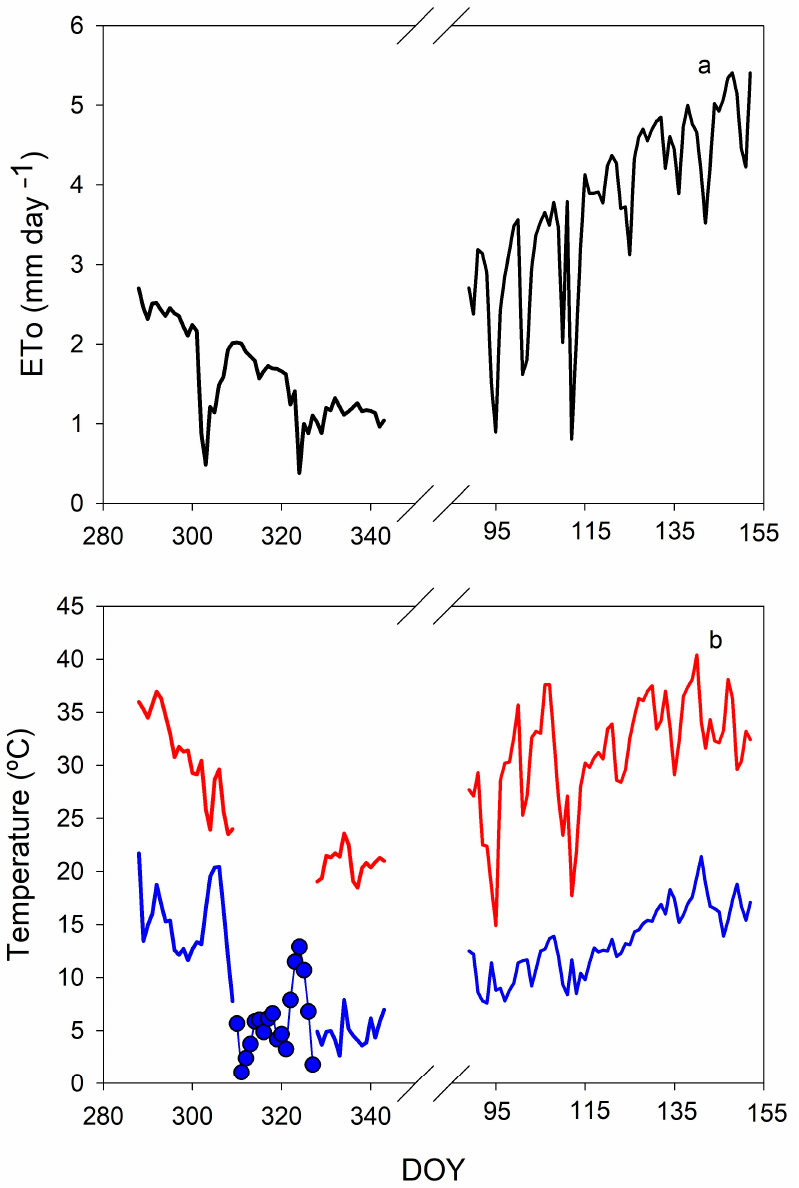
Figure 1. Pattern of reference evapotranspiration (ETo) ( a ) and maximum and minimum temperature ( b ) in the greenhouse during the experiments. Points in ( b ) are data on the minimum daily outdoor temperature.